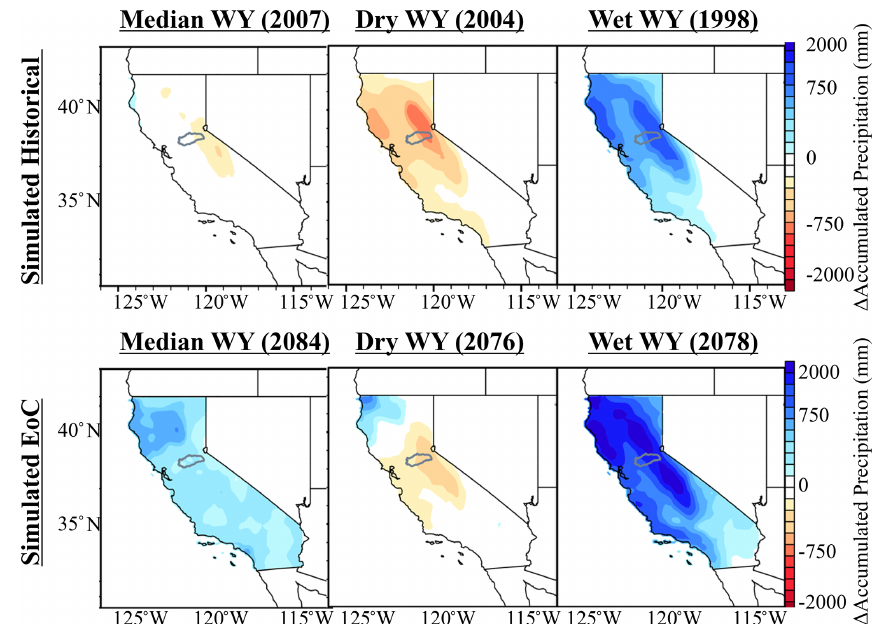
Figure 3. Precipitation spatial distributions of the dry, median, and wet water years (WYs) for the 30-year historical and EoC simulations relative to the climatological average (derived from the 30-year historical